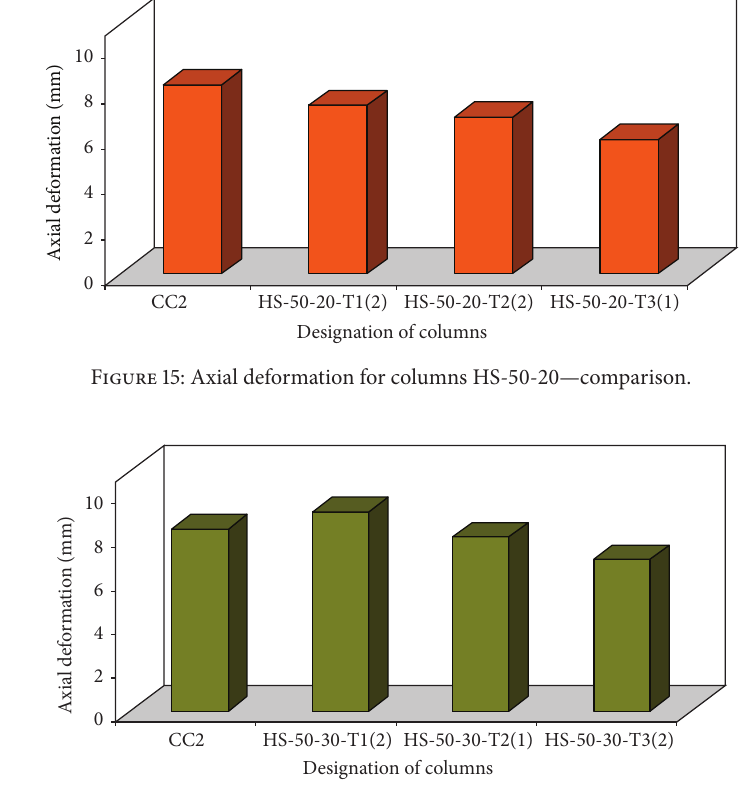
Figure 16: Axial deformation for columns